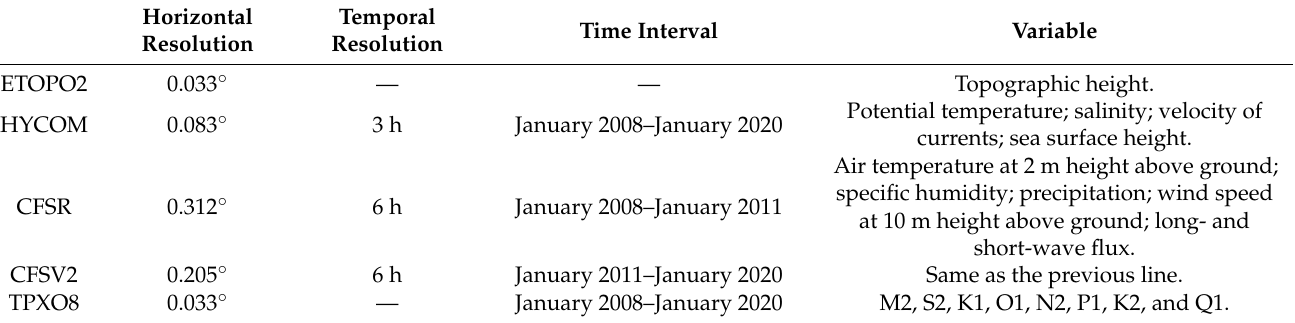
Table 1. Description of data